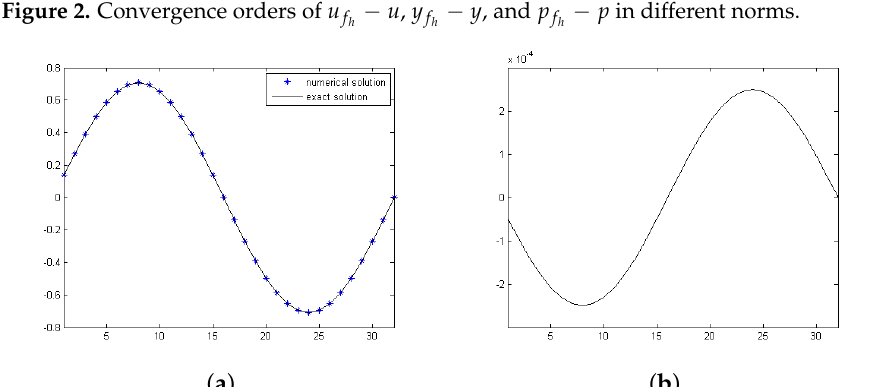
− p in different norms. − y , and p − u , y f h f h h